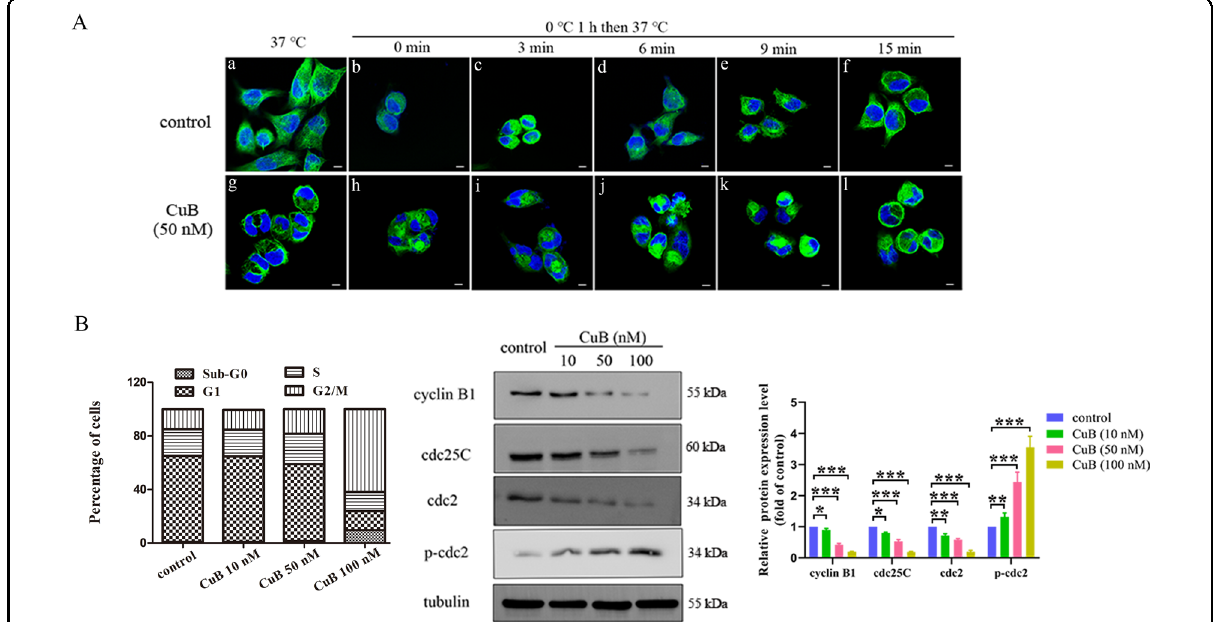
Fig. 5 Effects of CuB on cytoskeletal disruption and cell cycle arrest. A Representative images of intracellular microtubule networks of CNE1 cells treated with or without CuB (50 nM) 24 h, and then direct detected ( a and g ) by confocal laser scanning microscope (Leica Microsystems, Germany). In the microtubules reassembly assay, the untreated or treated cells were placed on ice for 1 h, subsequently warm at 37 °C for 0 ( b and h ), 3 ( c and i ), 6 ( d and j ), 9 ( e and k ) and 15 min ( f and l ) and then observed by confocal microscopy. The microtubules were stained with β -tubulin mouse antibody and Dylight ™ 488-Conjugated Goat Anti-Mouse IgG secondary antibody. The nucleus was stained by Hoechst33342. Scale bars: 10 μ m. ( B-C ) The effect of CuB on cell cycle arrest in CNE1 cells. CNE1 cells were treated with or without CuB at 10, 50, and 100 nM for 24 h, and then harvested cells were analysed for PI-stained DNA content by fl ow cytometry ( B ) or lysed for western blot analysis of cyclinB1, cdc25C, cdc2, and p-cdc2 ( C ). A minimum of 10,000 cells were harvested and analysed by EXPO32 ADC software. Quantitative analysis of western blots was performed by Image J (NIH, MD, USA). * p < 0.05, ** p < 0.01, and *** p < 0.001 vs . control group by t -test using GraphPad Prism 5.0. Data were presented as the mean ± SEM of three independent